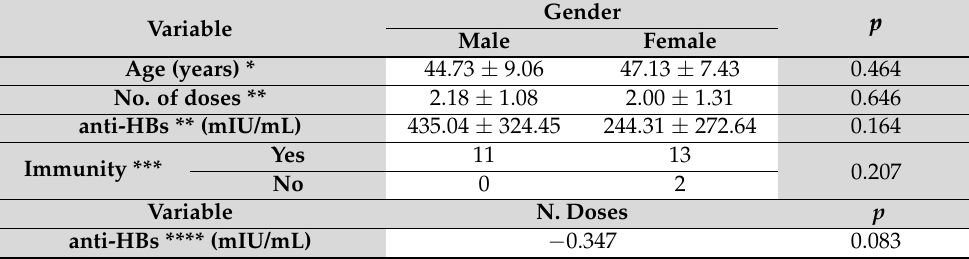
Table 2. Correlation between gender and anti-HBs titer with the remaining variables ( n = 26). Gender p Variable